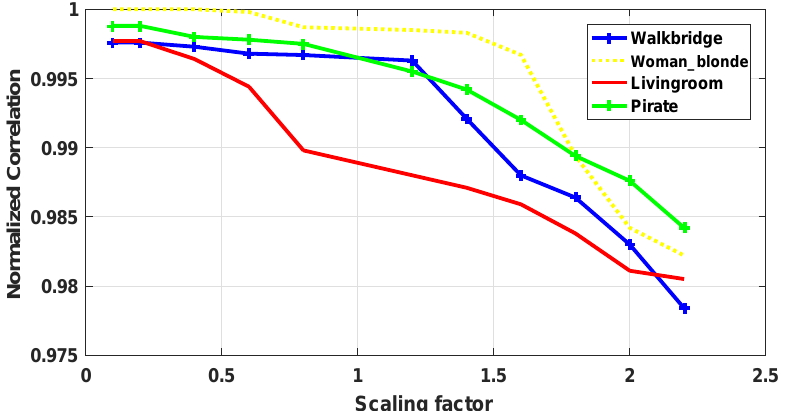
Figure 11. Robustness in terms of NC against scaling attack. Table 8. Robustness after rotation attack applied to thirty test